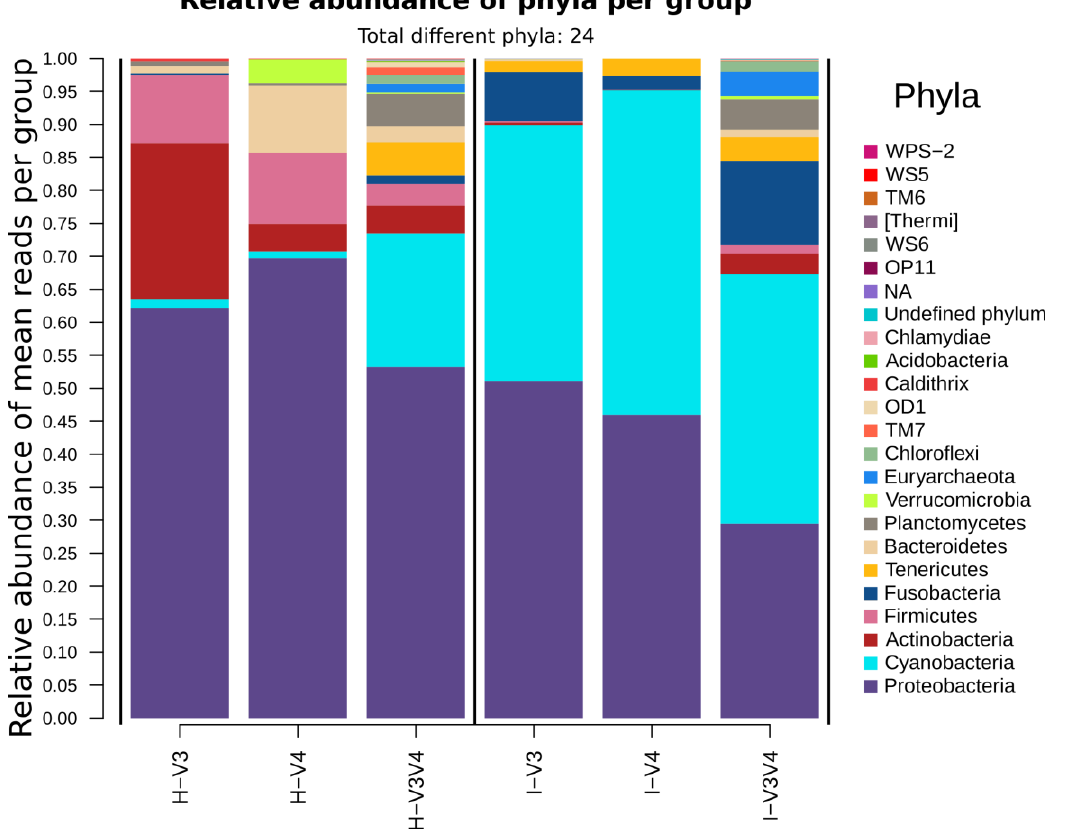
Figure 6. Relative abundances at the phylum level per region/organ groups. Phyla are ordered by abundance. Groups on the left show hepatopancreas samples (H), while groups on the right show intestine samples (I).